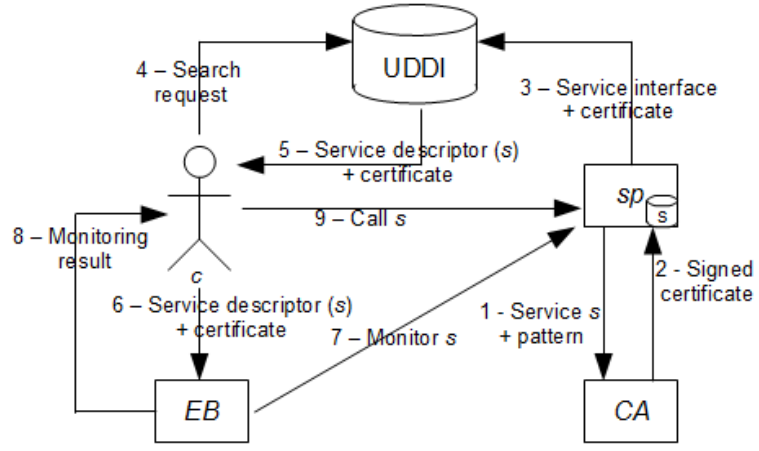
Figure 21. An SOA enhanced with security and reliability certification.